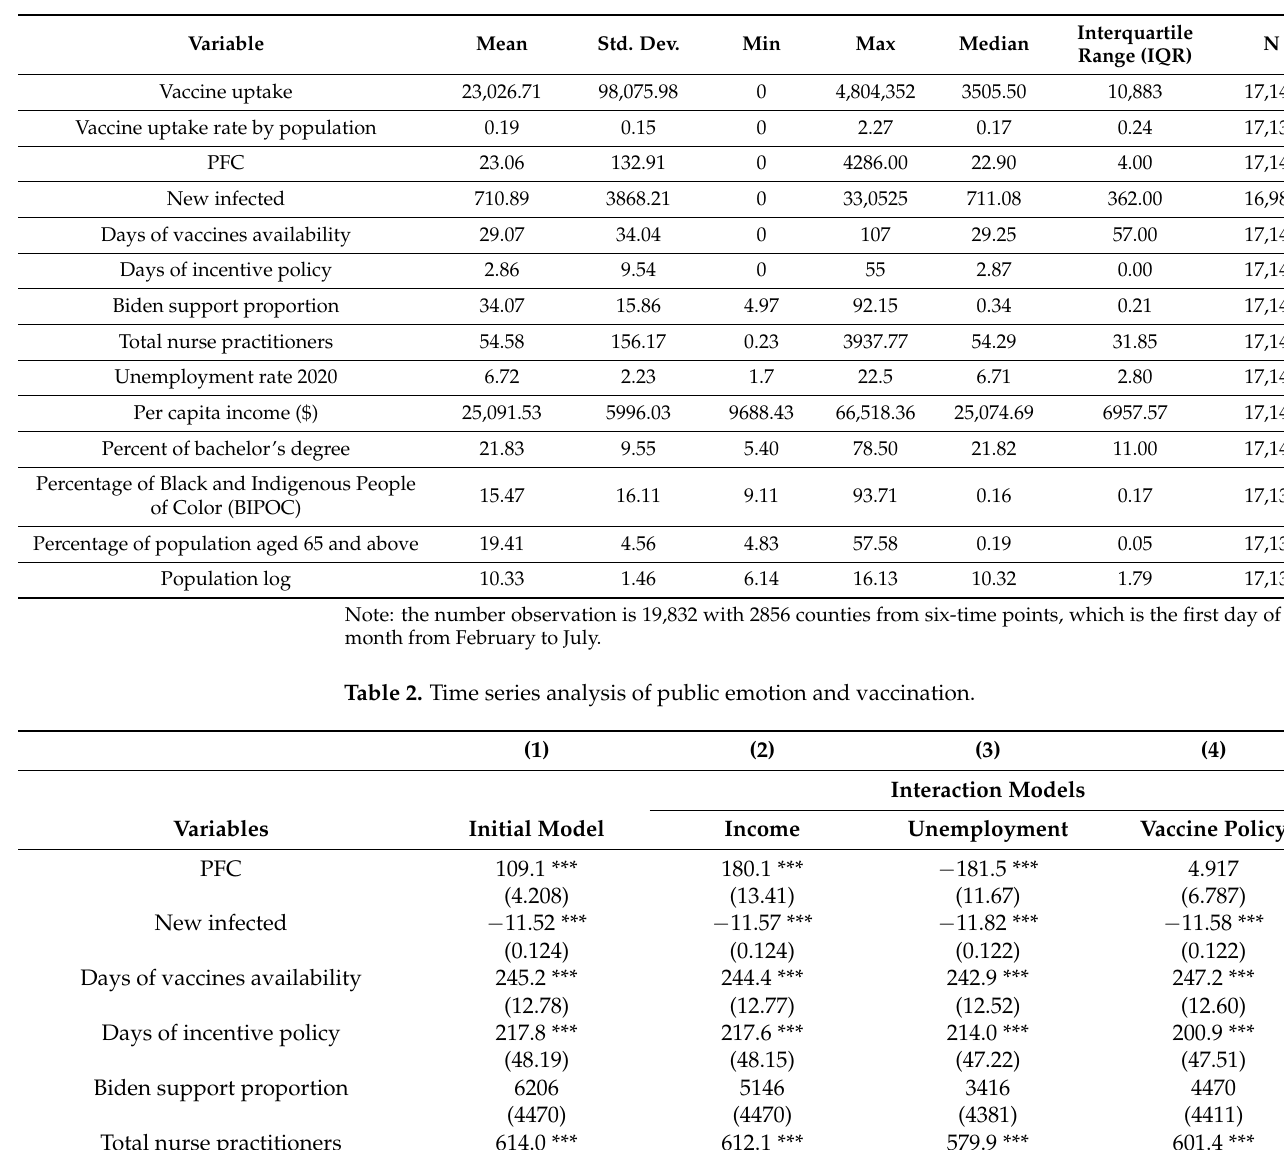
Table 1. Descriptive Statistics.